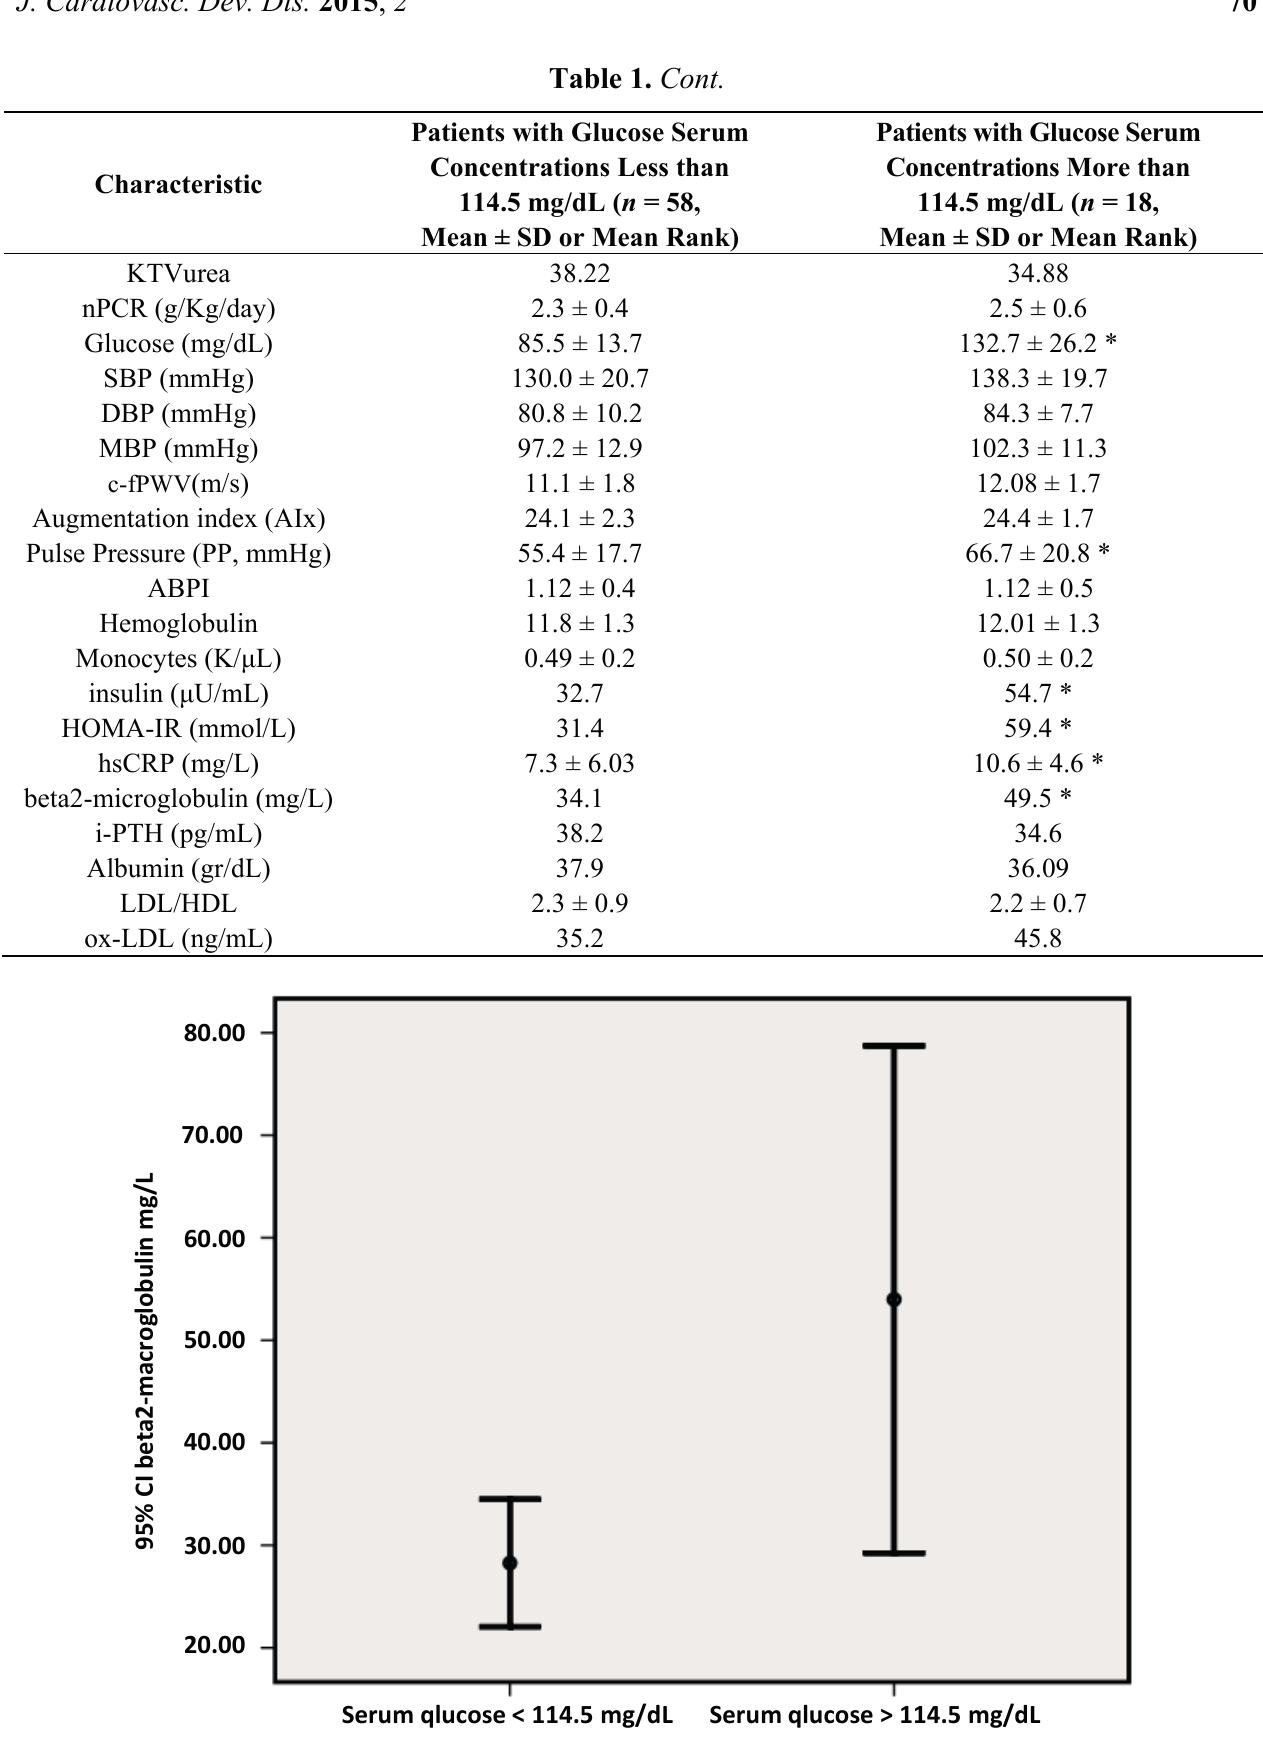
Figure 1. Beta2-microglobulin serum concentrations in patients on hemodiafiltration with glucose serum concentrations less and more than 114.5 mg/dL ( p =